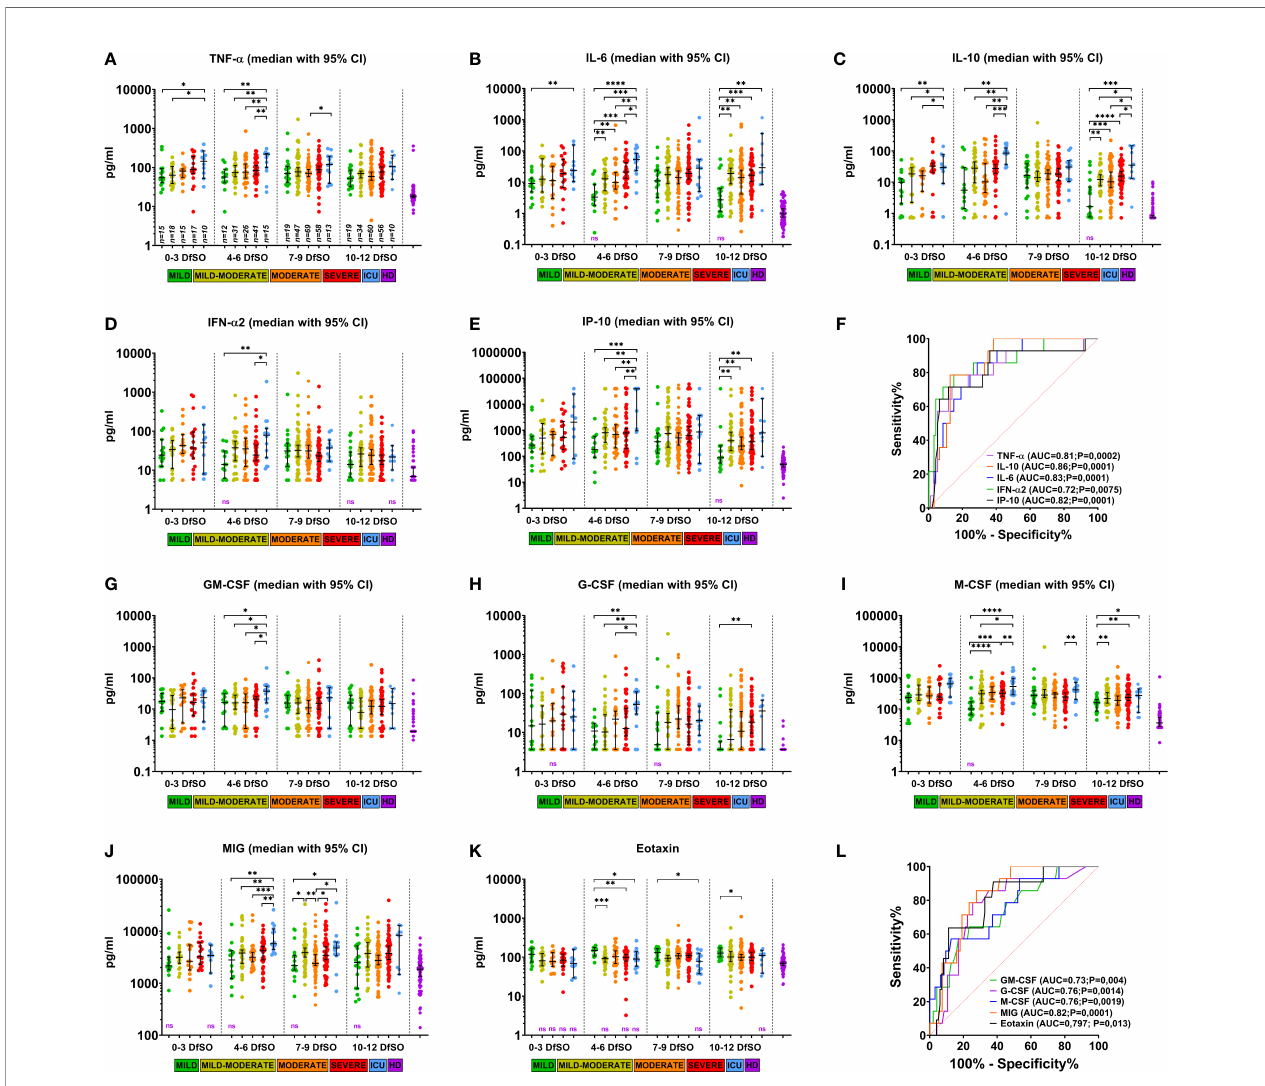
FIGURE 4 | Dynamics of serum cytokine levels demonstrating differences between severity groups of COVID-19 patients in the fi rst 12 days after illness onset. (A – E) and (G – K) show serum levels of TNF- a , IL-6, IL-10, IFN- a 2, IP-10, GM-CSF, G-CSF, M-CSF, MIG, eotaxin in patients with different COVID-19 severities at days 0 – 3, 4 – 6, 7-9, and 10-12 DfSO. Dots show individual measurements, and lines represent medians with 95% CIs. Statistical analyses were performed with a two- tailed Mann – Whitney U-test for nonparametric comparison. All signi fi cant differences between severity groups are shown by asterisks: *p<0.05, **p<0.01, ***p<0.001, ****p<0.0001. For comparisons between any of severity groups and HD signi fi cant differences (p<0.05) are not shown and not signi fi cant differences provided as «ns» written in violet down of each plot. (F, L) demonstrate ROC curves of serum cytokine levels on 4-6 DfSO to predict ICU requirement during hospitalization. The ROC curve of eotaxin to predict mild